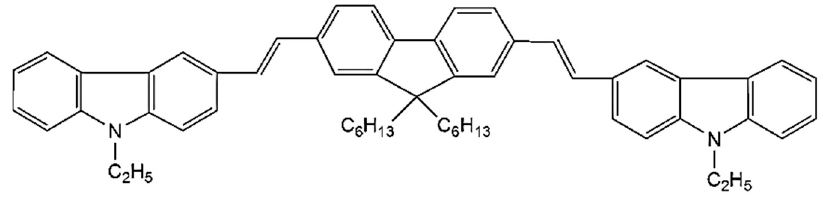
Figure 1. The molecular structure of 1,4-bis(9-ethyl-3-carbazo-vinylene)-9,9-dihexyl-fluorene (BECV-DHF).